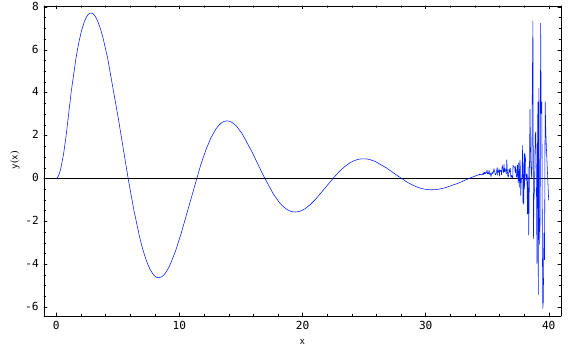
Fig. 7: The Adomian Decomposition Method series solution of Bagley-Torvik equation. The divergence after a certain time is ap-